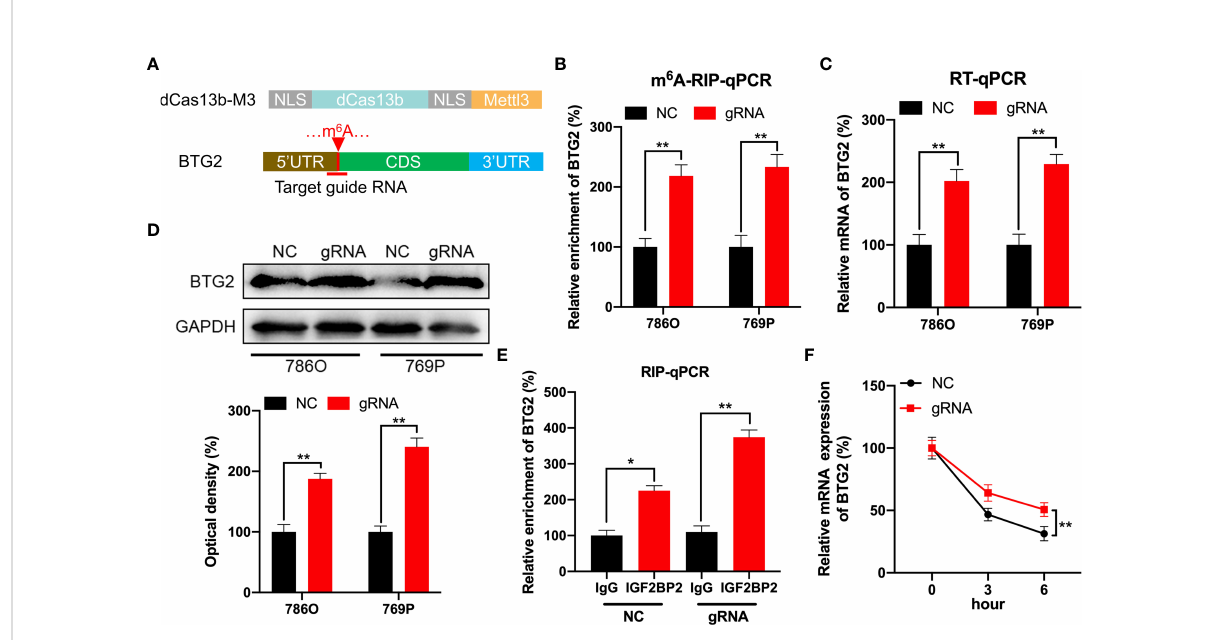
FIGURE 5 CRISPR/dCas13b-METTL3 speci fi cally targets m 6 A methylation of BTG2 to regulate its expression. (A) Positions of m 6 A sites within BTG2 mRNA along with target guide RNA regions. (B – D) . The m 6 A (B) , mRNA (C) and protein levels (D) of BTG2 in RCC cells transfected with dCas13b-M3 combined with gRNA control or gRNA for BTG2, respectively. (E) A RIP-qPCR analysis of BTG2 mRNA is performed by using antibodies against IGF2BP2 on 786O cells transfected with dCas13b-M3 combined with gRNA control or gRNA for BTG2, respectively. (F) The mRNA expression levels of BTG2 in 786O cells transfected with dCas13b-M3 combined with gRNA control or gRNA for BTG2 and treatment with ActD for indicated times. * P<0.05, **